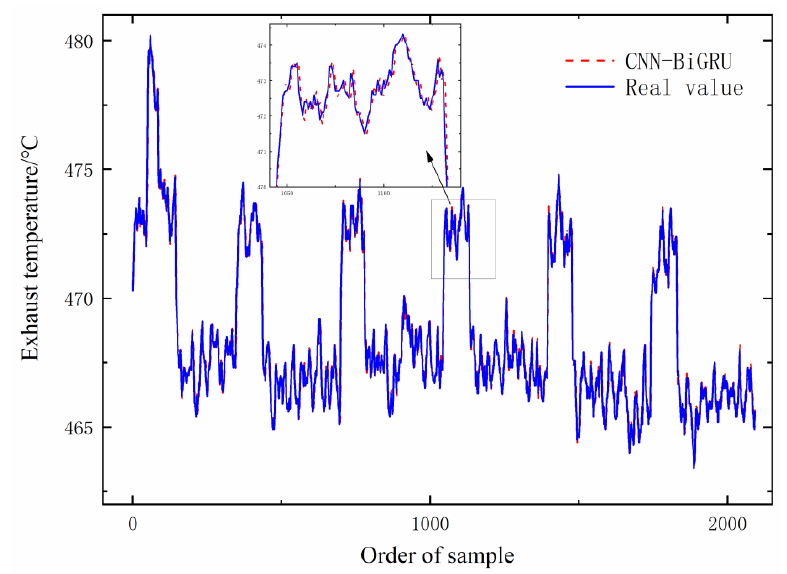
Figure 5. CNN-BiGRU prediction